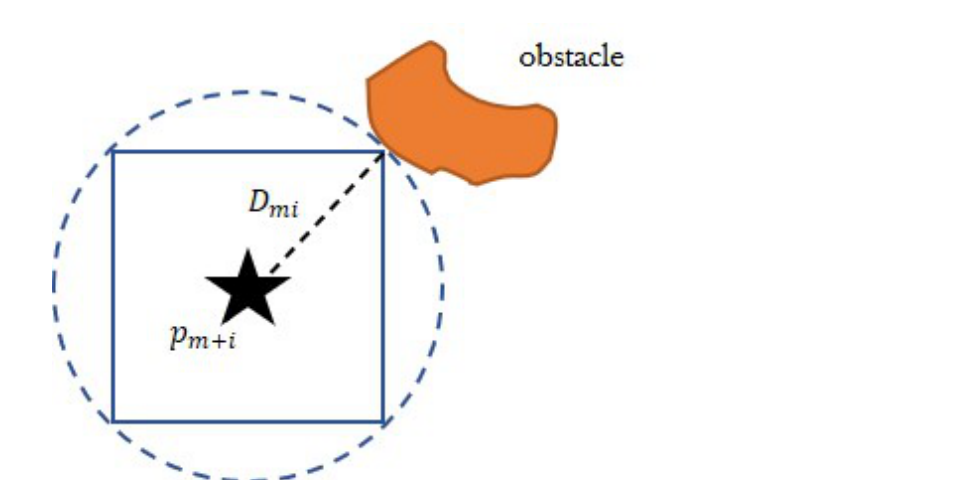
Figure 10. Generating the corridor size for target spots found on SPH 2 s . If the corridor intersects with s and p (cid:48) s corridor, then the spots will be recorded in the target spots the p (cid:48) m + i m + i + 1